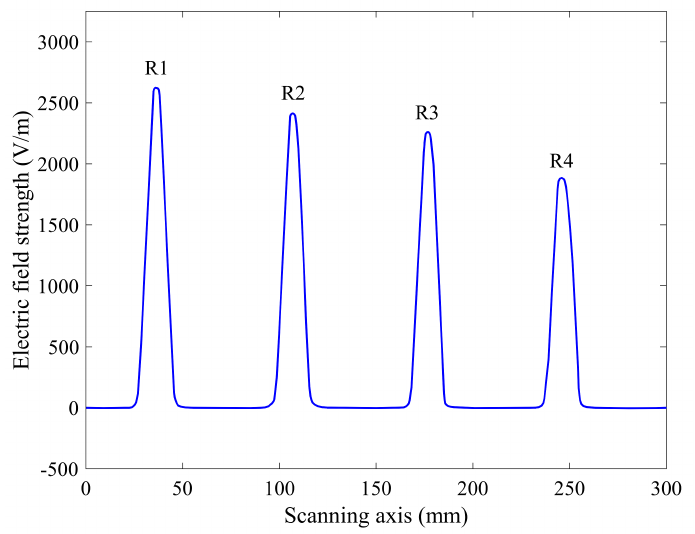
Figure 7. FEM result showing the electric field strength (V/m) of the coplanar capacitive probe inspecting a concrete slab composed of various diameters of rebars. Rebar’s diameters are 5/8, 4/8, 3/8 and 5/16 inches, and their names were abbreviated as R1, R2, R3 and R4 from left to right,